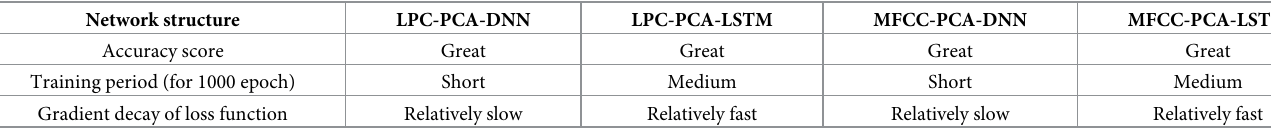
Table 6. Loss functions between PCA-DNN model and PCA-LSTM model.